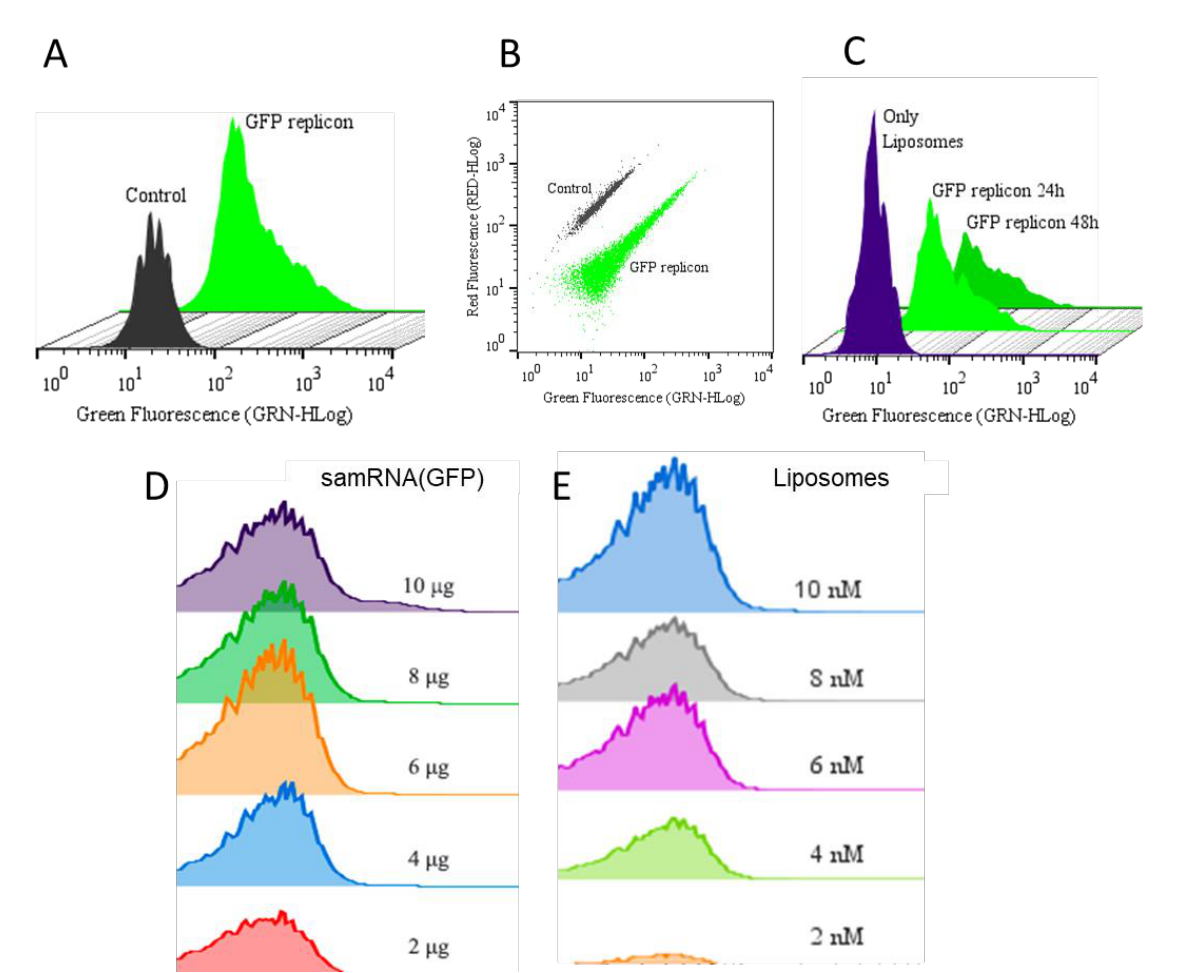
Figure 4. Comparison of samRNA or lipid composition quantities in transgene expression in vitro. ( A ) Representative histograms of Vero cells expressing GFP 24 h after transfection with the GFP- expressing replicon in comparison to an untransfected control. ( B ) Dot plot comparing the populations described in ( A ). ( C ) Representative histograms of GFP expression 24 h and 48 h after transfection with samRNA encoding GFP encapsulated in liposomes in comparison to a control transfected with empty liposomes. ( D ) Representative histograms of GFP expression dependent on the amount of transfected replicon (2 μg, 4 μg, 6 μg, 8 μg or 10 μg of transfected replicons) in HEK293T cells 24 h after transfection. ( E ) Representative histograms of GFP expression in dependence on the concentration of liposome used (2 nM, 4 nM, 6 nM, 8 nM or 10 nM) to deliver 1 μg of GFP replicon to HEK293T cells 24 h after transfection.